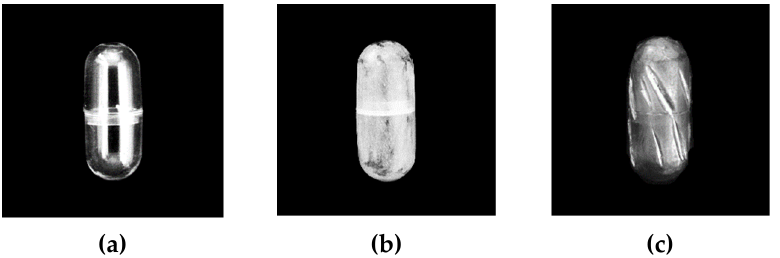
Figure 2. Photo of surface texture of capsule ( a ) without modification (smooth), ( b ) roughened, and ( c ) weak lines.